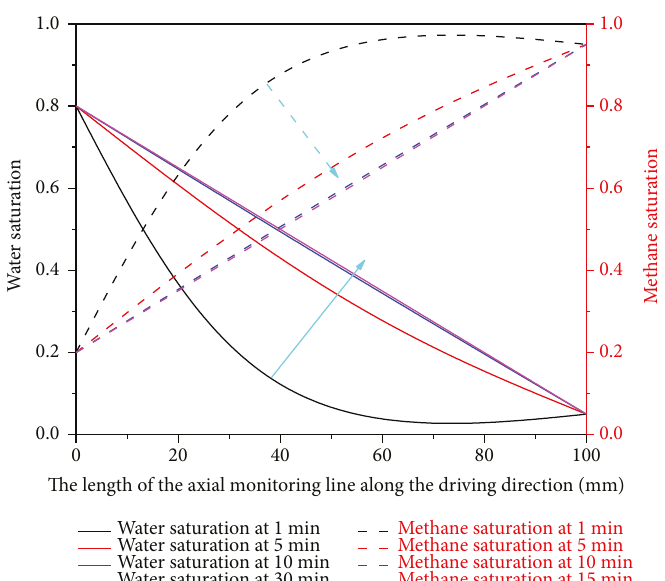
Figure 9: Space-time distribution curve of the water-methane two-phase saturation along the driving direction.